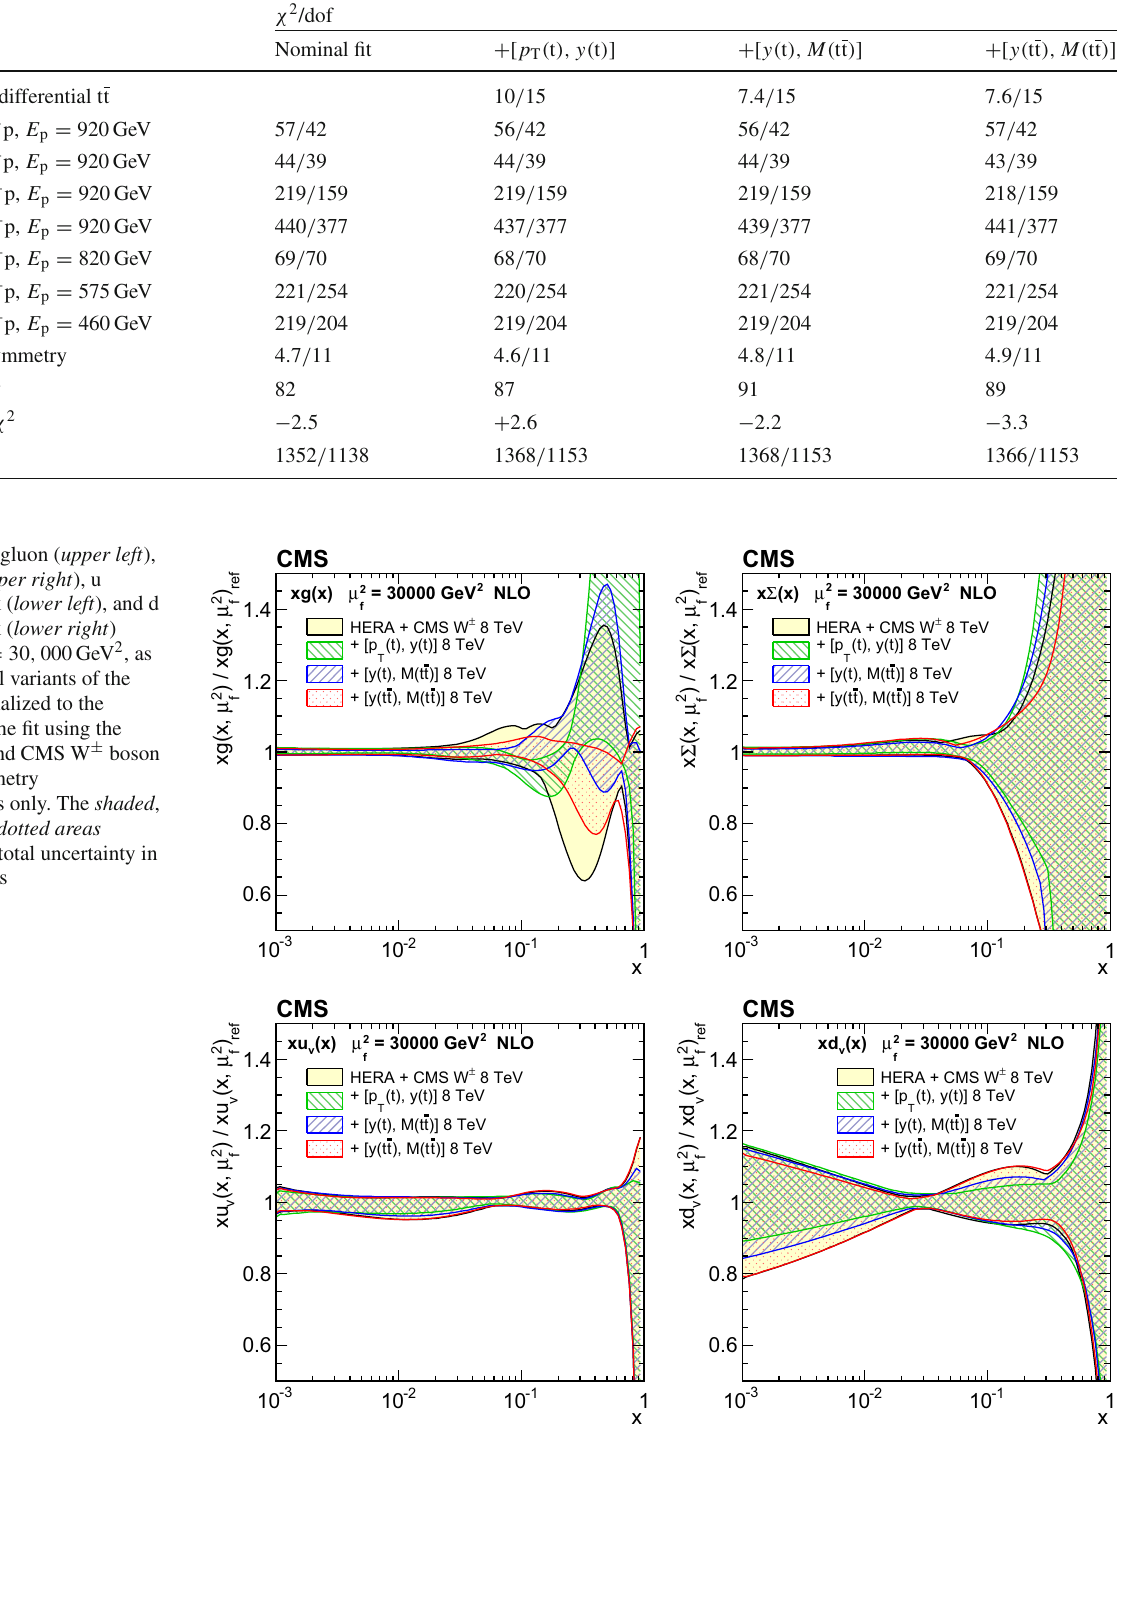
each data set, with the electron energy being E e = 27 . 5GeV, CC and NC stand for charged and neutral current, respectively. The correlated χ 2 and the log-penalty χ 2 entries refer to the χ 2 contributions from the nuisance parameters and from the logarithmic term, respectively, as described in the text